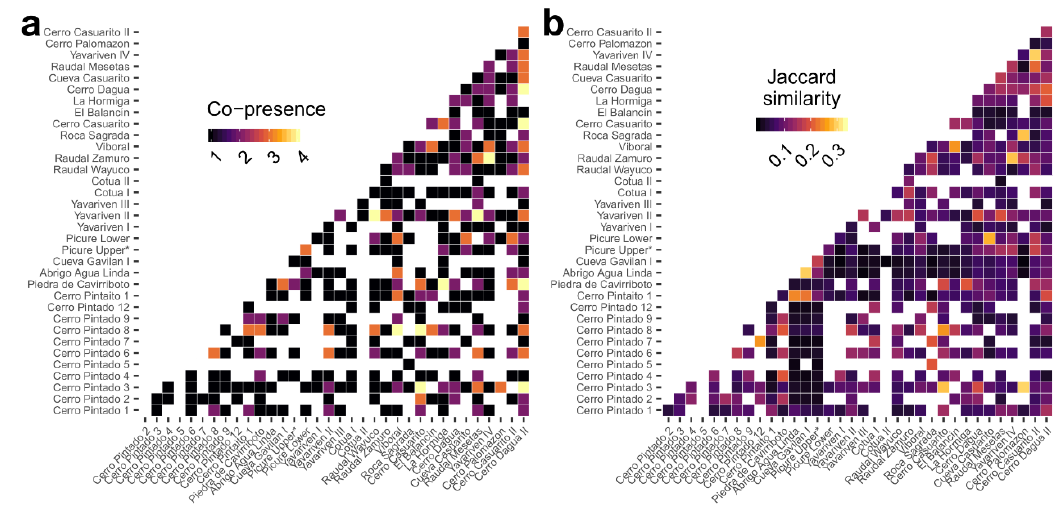
Figure 4. Correlation matrices for co-presence of motifs ( a ) and Jaccard similarity ( b ). Axes are consistent between each matrix to facilitate comparisons. Pairwise comparisons with a value of 0, indicating no similarity, are hollow. Note that many weakly similar sites score very low (dark purple) on the Jaccard index, whereas co-presence has sharper cut-off points.